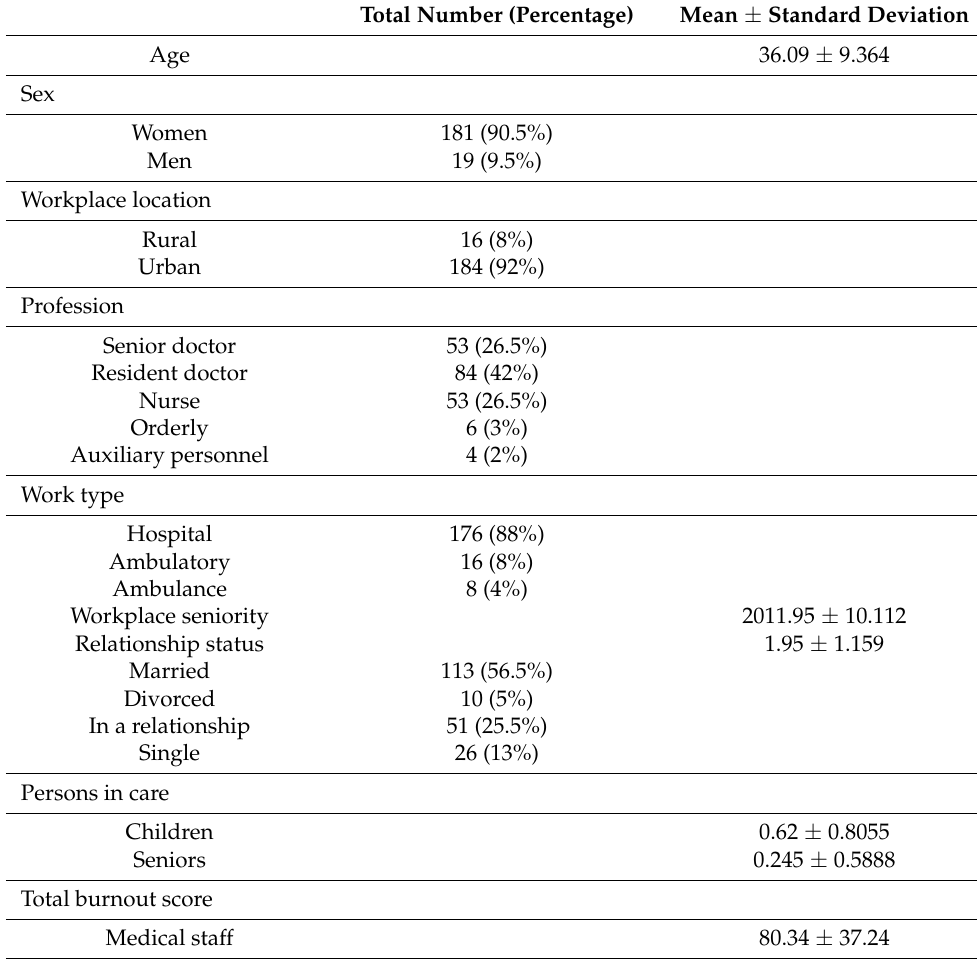
Table 1. General data and demographic aspects of the study